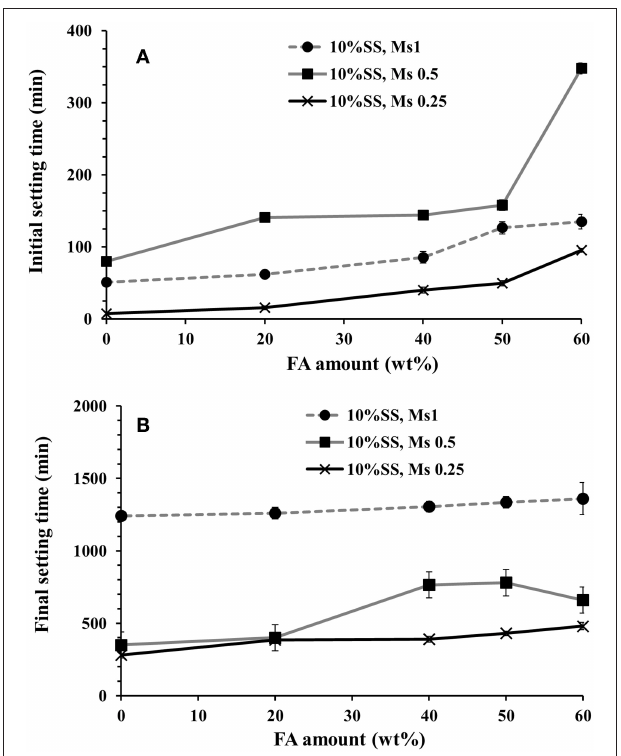
FIGURE 2 | (A) Initial setting times and (B) final setting times of pastes activated with different doses of sodium silicate (SS) with alkali modulus M s = 1.